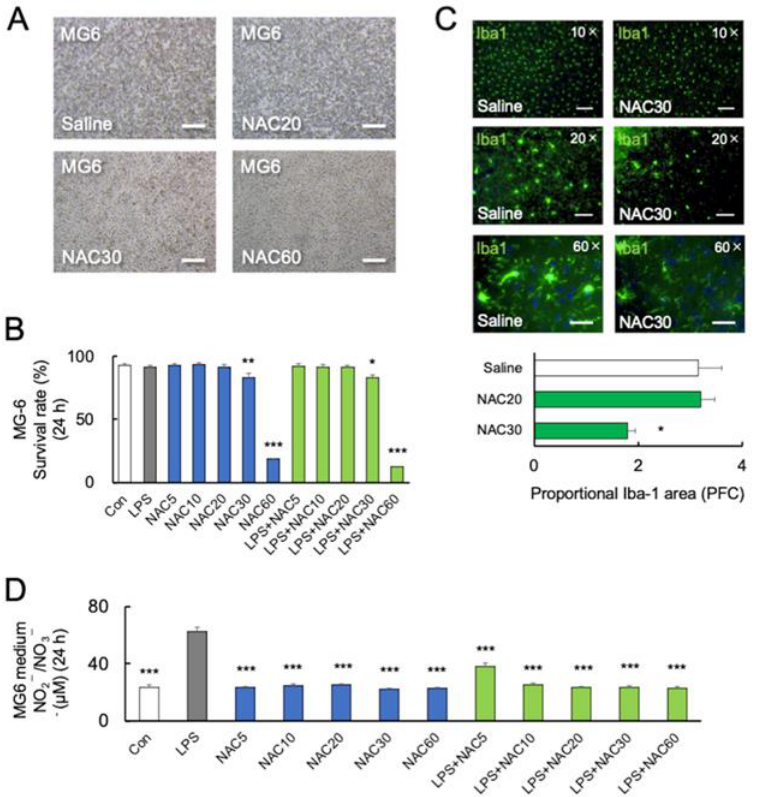
Figure 2. Effects of NAC on LPS-induced MG6 mortality. ( A , B ) Representative images and quanti- tative analyses of MG6 viability at 24 h with different doses of NAC treatments (n = 6). * p < 0.05, ** p < 0.01, *** p < 0.001, vs. control (Con). Scale bars, 250 μm. ( C ) Representative images and quantitative analyses of immunostaining for Iba-1 in the prefrontal cortex of C57BL/6J mice treated with saline or NAC (30 mM) 24 h after the last treatments (n = 4). Iba-1 positive microglia are shown in green. * p < 0.05, vs. saline (Con). Scale bars of upper, middle, and lower parts: 100 µ m, 50 µ m, and 20 μm. ( D ) NO x synthesis after treatment with LPS (0 and 10 ng/mL), and NAC (0, 5, 10, 20, 30, and 60 mM) in MG6 cells after 24 h (n = 6). *** p < 0.001, vs. LPS. All data are presented as MEAN ± SEM.